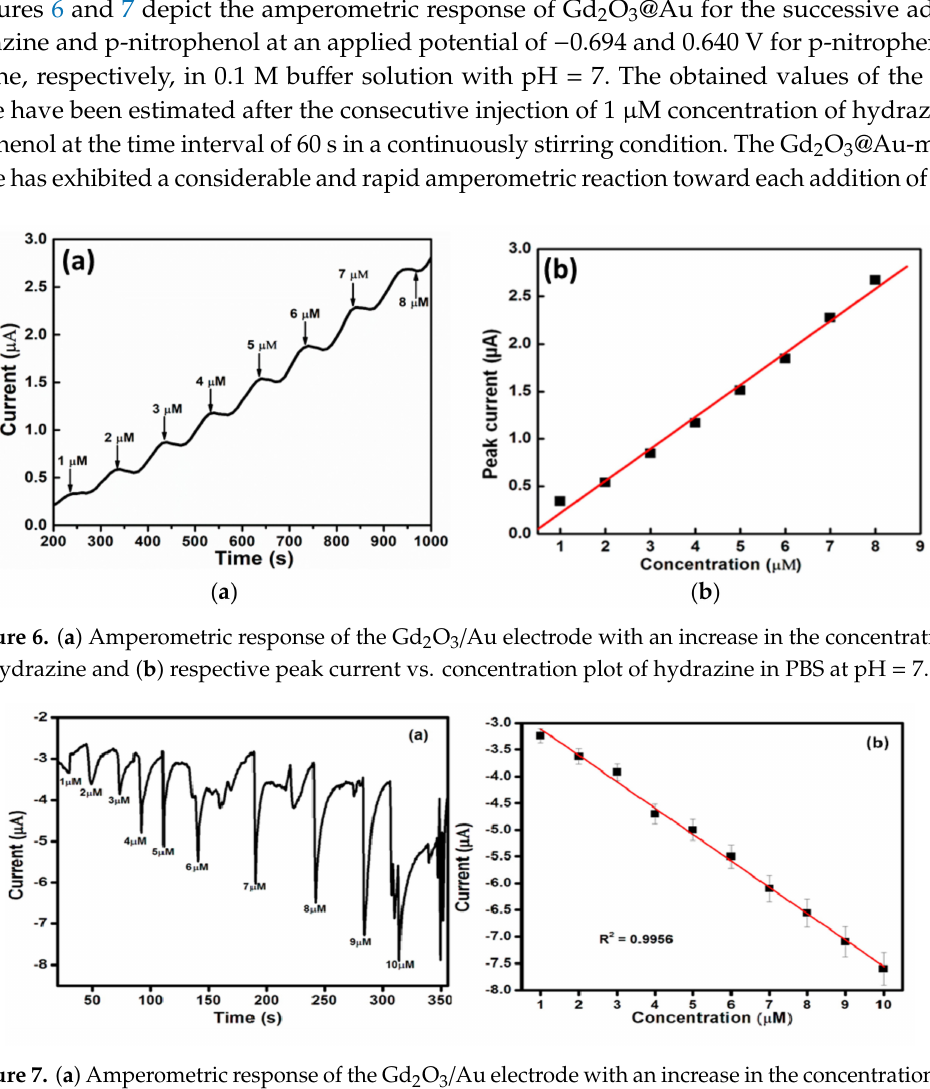
Figure 7. ( a ) Amperometric response of the Gd 2 O 3 / Au electrode with an increase in the concentration of p-nitrophenol and ( b ) respective peak current vs. concentration plot of p-nitrophenol in PBS at pH =